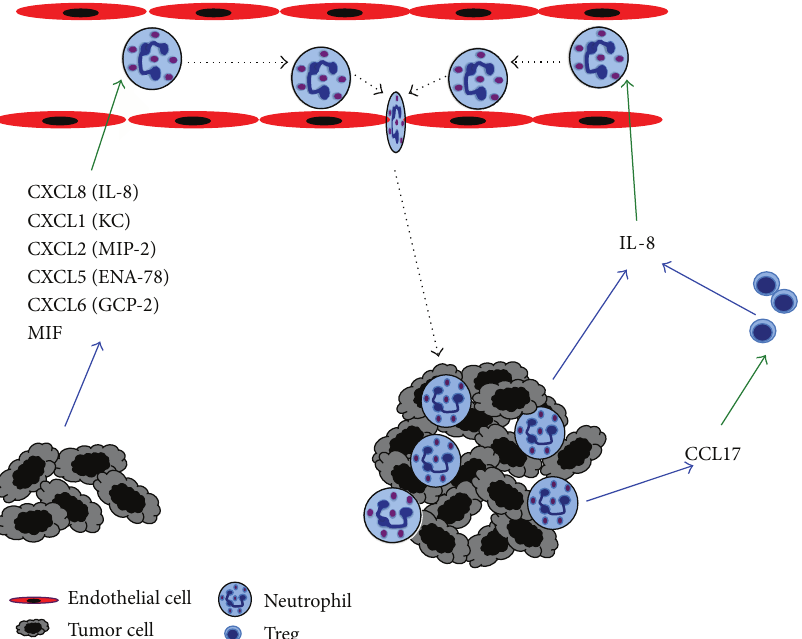
Figure 1: Mechanisms of neutrophil recruitment to tumors. Tumor cells produce many chemokines, such as CXCL1 (KC), CXCL2 (MIP-2), CXCL5 (ENA-78), CXCL6 (GCP-2), CXCL8 (IL-8), and MIF, which are chemoattractants for neutrophils. These cells then migrate out of the blood circulation into the tumor. Tumor-associated neutrophils can also produce CCL17, an important chemoattractant for regulatory T cells (Treg). These inhibitory Treg in turn produce more IL-8, the most potent chemoattractant for neutrophils, creating a positive loop for more neutrophil infiltration into the growing tumor. Blue arrows denote molecules secreted by cells. Green arrows denote the action of molecules on cells. Dotted lines denote cell